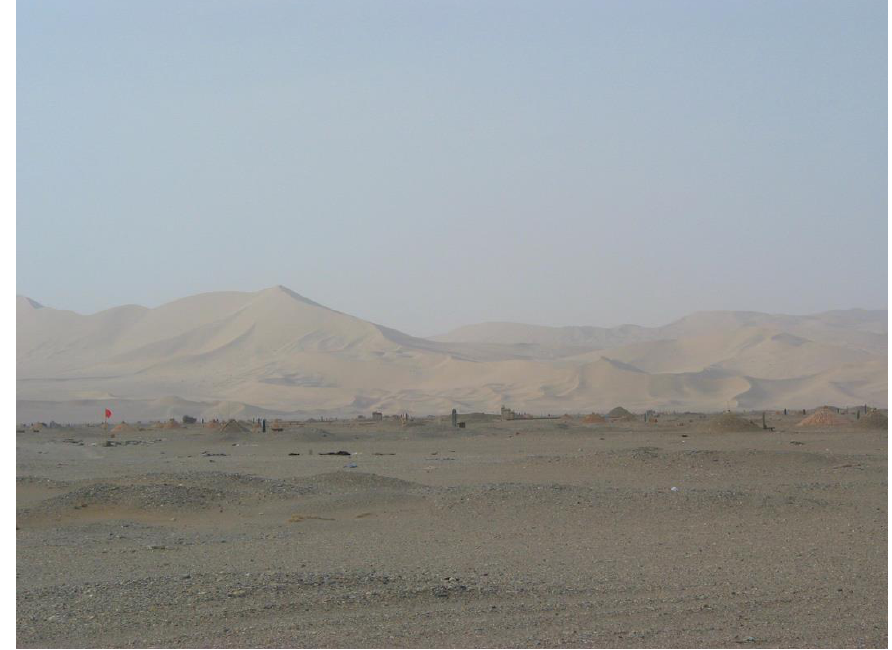
Figure 6. Tomb mounds and enclosures at Foyemiaowan, gravel and sand, Dunhuang, Western Jin dynasty, 265–317 CE.